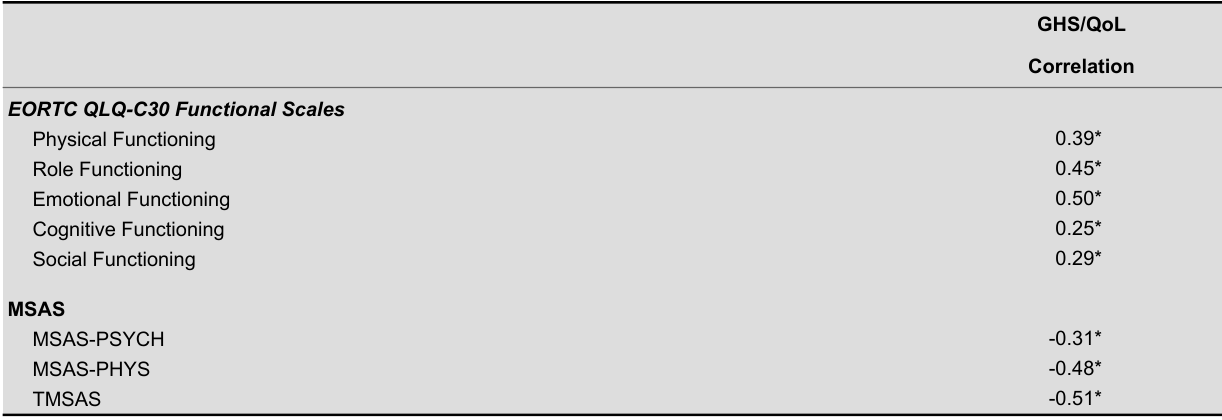
Pearson Correlation Between Global Health Status/Quality of Life and Functioning Scales, MSAS